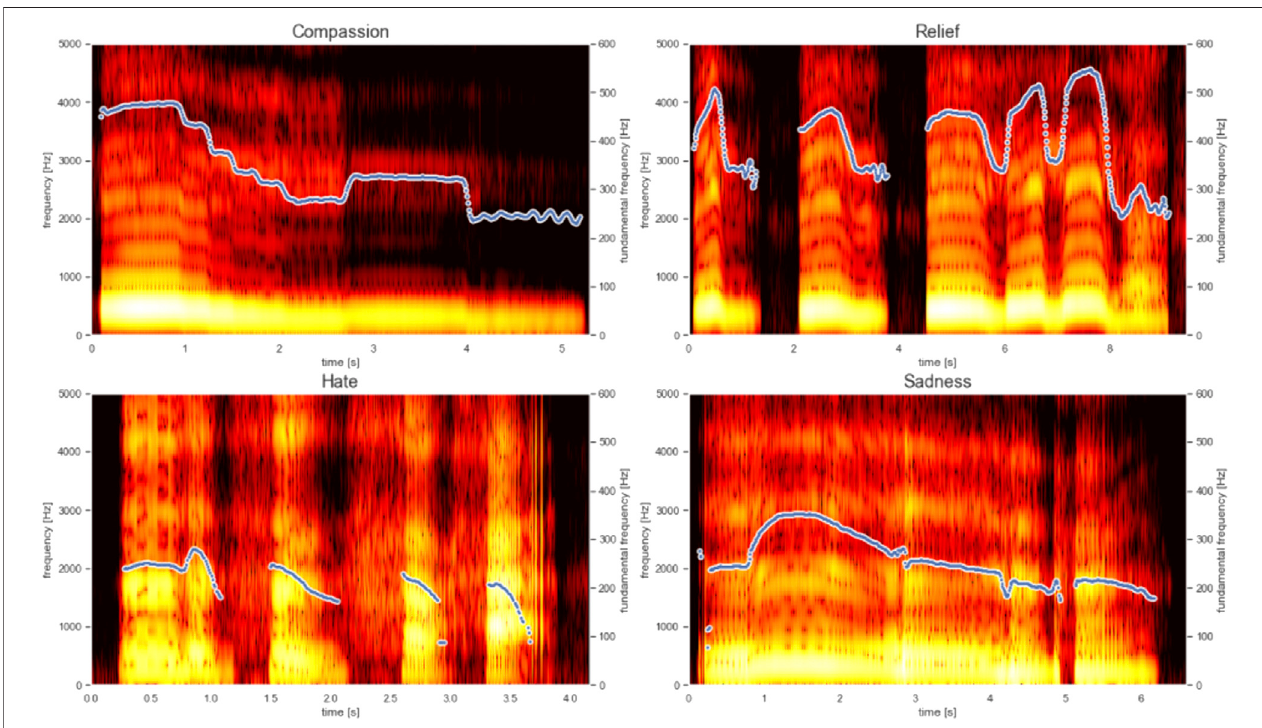
FIGURE 3 | Spectogram of musical prosody phrases (blue line indicates pitch contour).